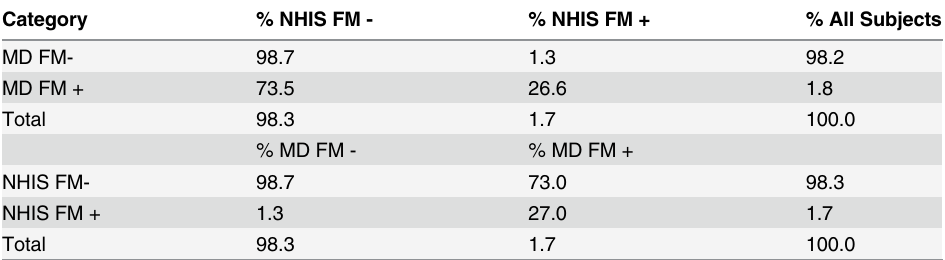
Table 1. Fibromyalgia status according to physician diagnosis (Column 1) and NHIS criteria (Top 3 rows) and NHIS criteria (Column 1) and physician diagnosis (Bottom 3 rows) in 2012 National Health Interview